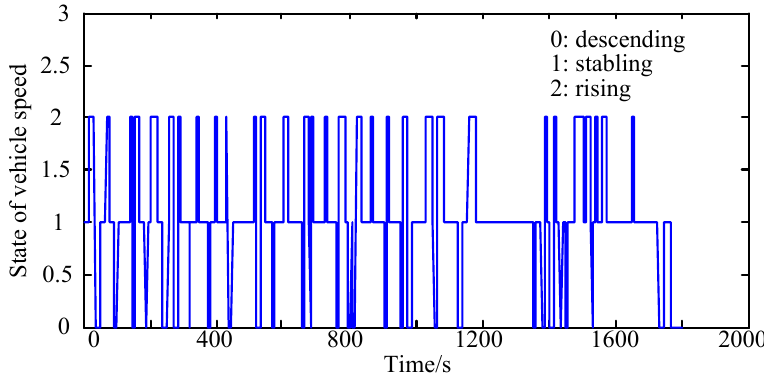
Figure 7. State of vehicle speed under a WLTP driving cycle.